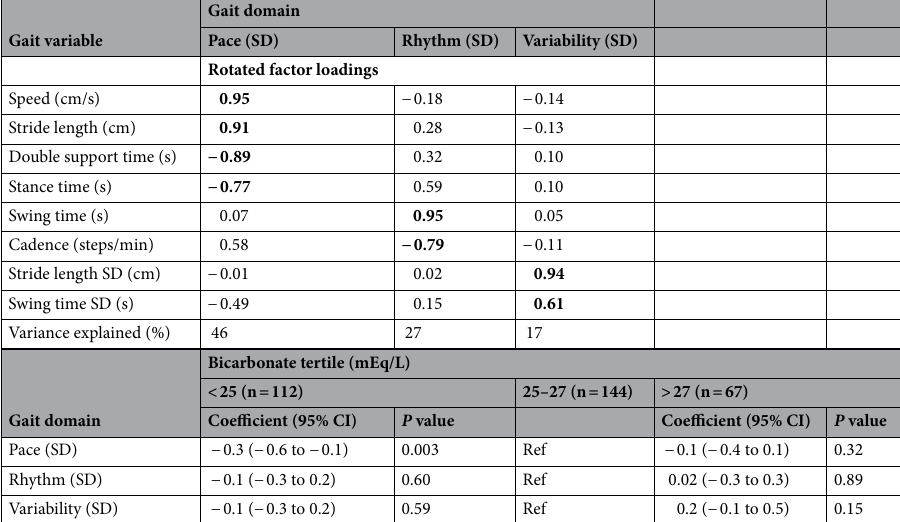
Table 3. Associations of serum bicarbonate tertiles with gait domains using factor analysis. Top: Rotated factor loadings of eight gait variables using factor analysis. Factor analysis was performed using the principal component method with varimax rotation. The highest loading variables are in bold. Bottom: Multivariable linear regression adjusting for age, sex, race, education, smoking status, body mass index (BMI), number of comorbidities, number of medications, diuretic use, diagnosis of neuropathy, cardiovascular disease, hypertension, diabetes, emphysema or chronic obstructive pulmonary disease (COPD), blood urea nitrogen (BUN), and estimated glomerular filtration rate (eGFR) was performed. The reference group was serum bicarbonate 25–27 mEq/L (middle tertile). N = 323 total. CI confidence interval, Ref reference group, SD standard